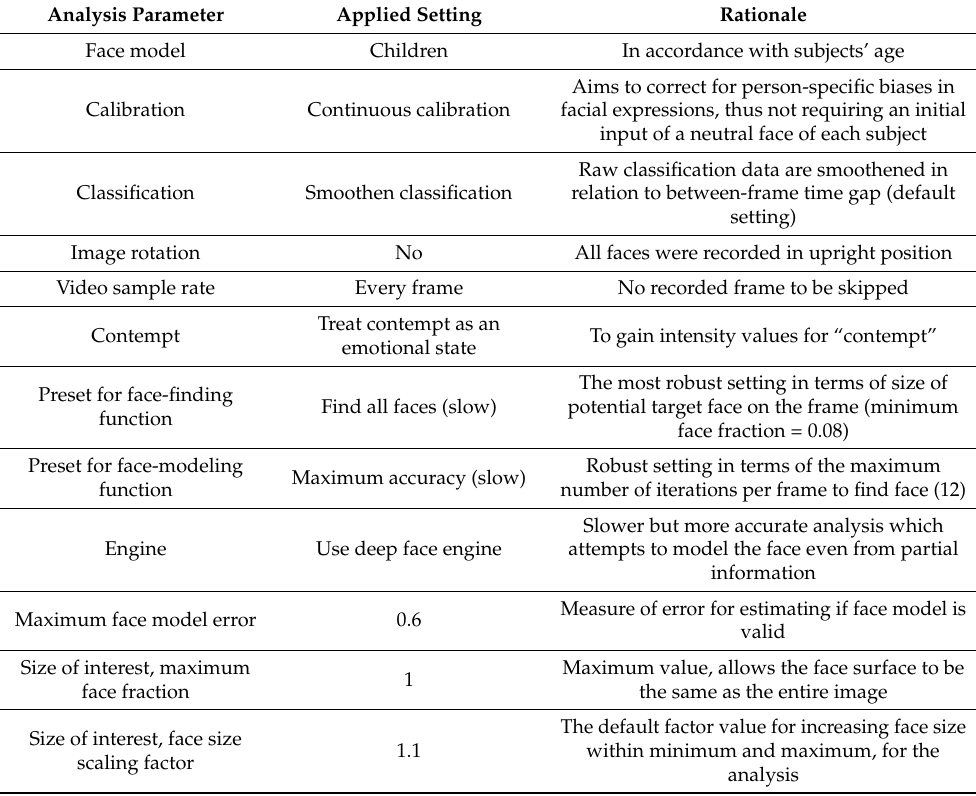
Table A1. Relevant FR8 analysis settings and their